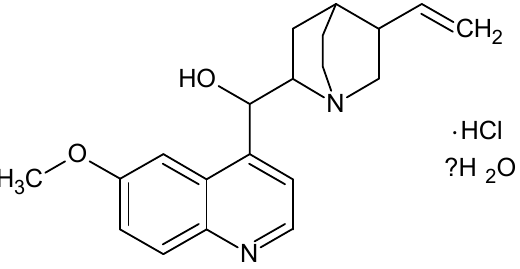
Figure 4. The structural formula of Qi (ChemSketch 12.1.0.31258).